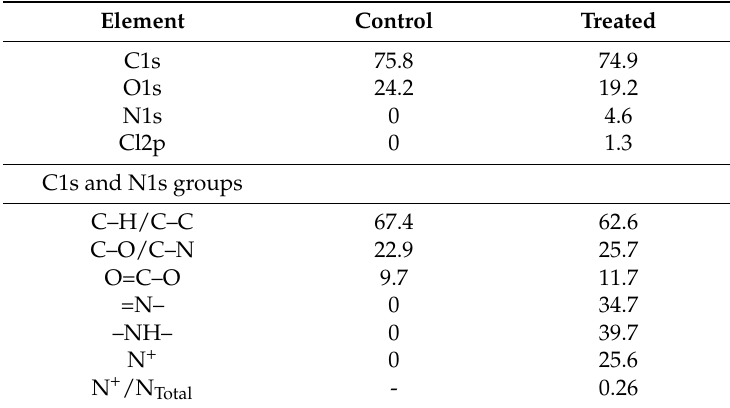
Table 2. Quantification analysis of elements on control and optimal PET yarns.